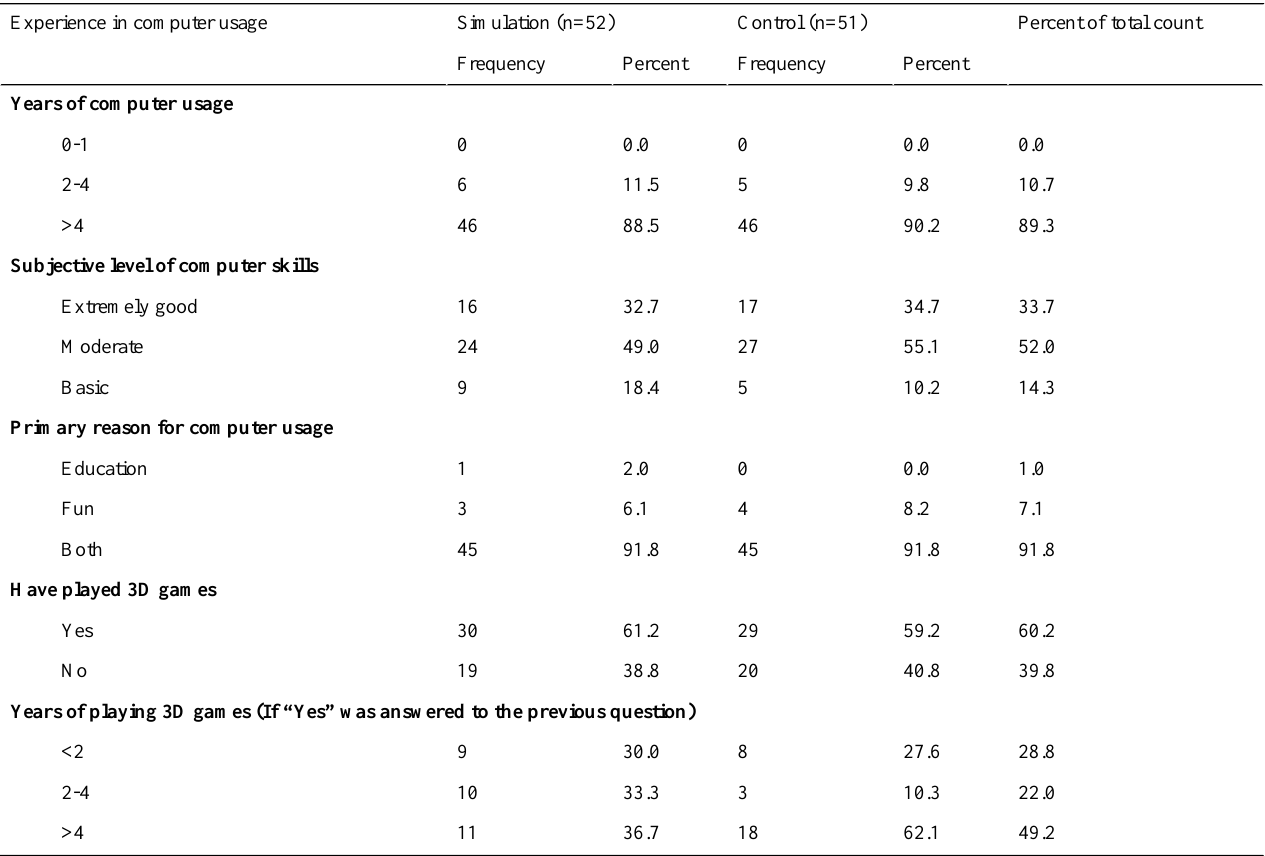
Table 4. Computer skills profile of the participants (N=103).